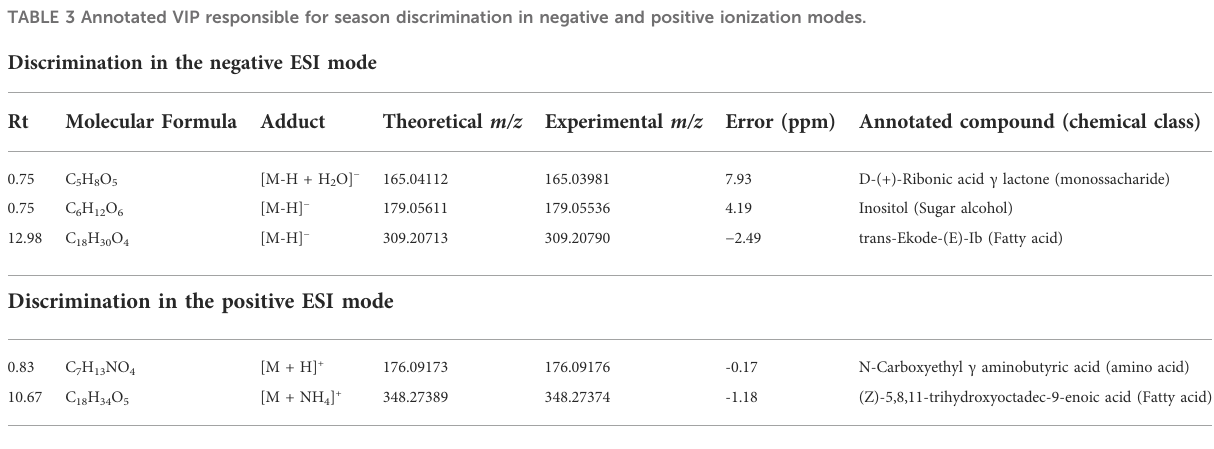
TABLE 3 Annotated VIP responsible for season discrimination in negative and positive ionization